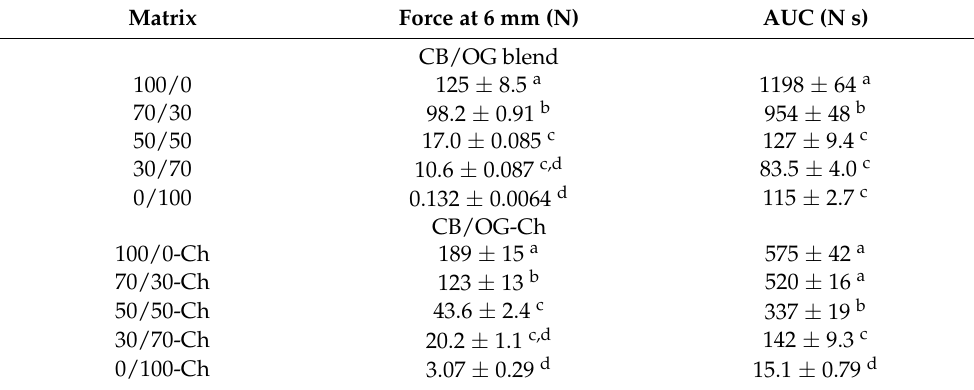
Table 7. Textural penetration parameters obtained at 20 ◦ C in the different formulated CB/OG blends and CB/OG-based chocolate (CB/OG-Ch) counterparts. Matrix Force at 6 mm (N) AUC (N